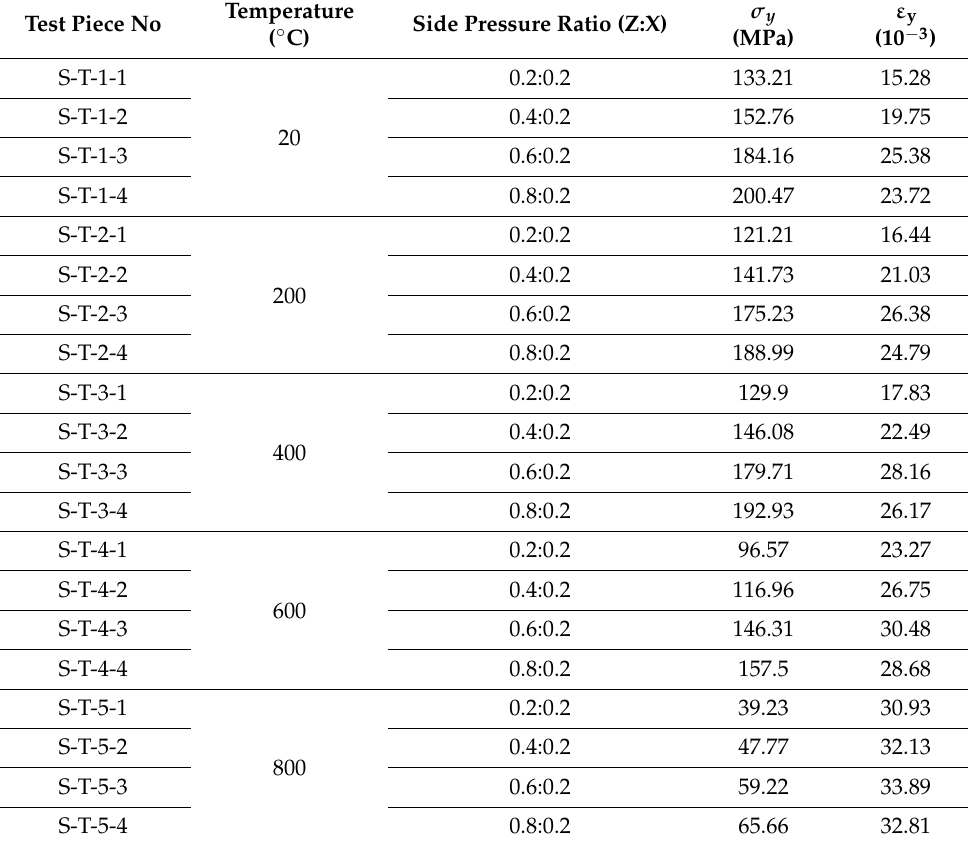
Table 7. High-temperature true triaxial static compression test results of